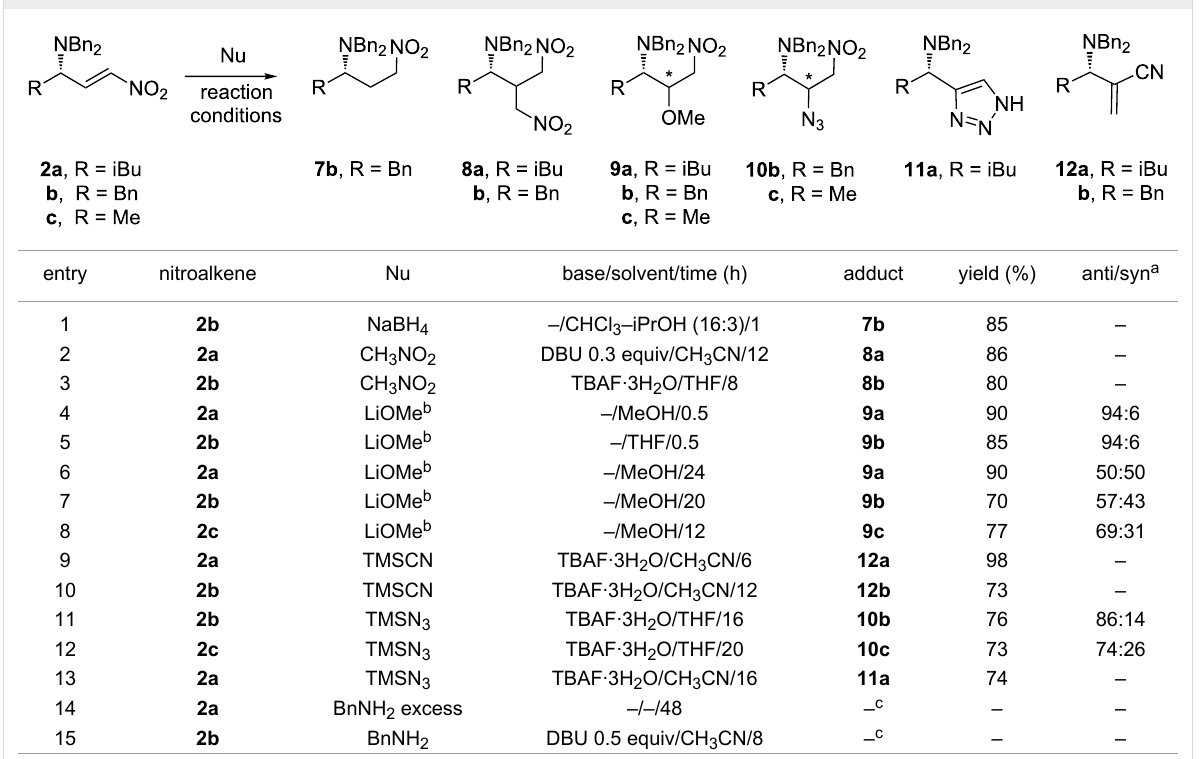
Table 1: Reactivity of 2a–c with different